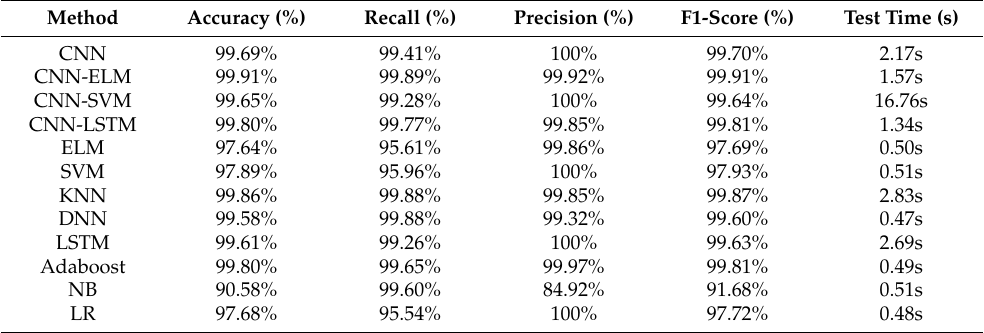
Table 11. Comparison results of CNN-ELM models with 12 feature subsets based on the InSDN